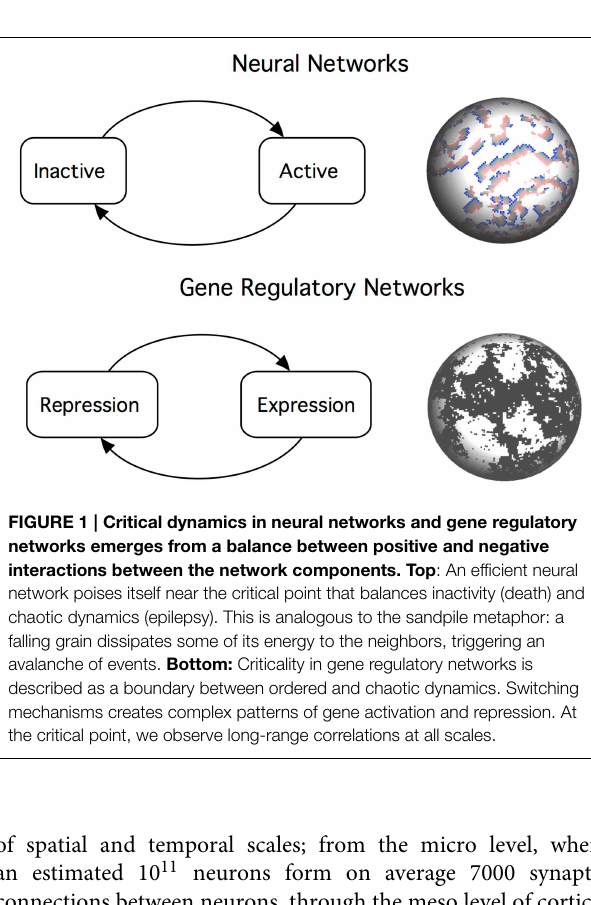
of spatial and temporal scales; from the micro level,